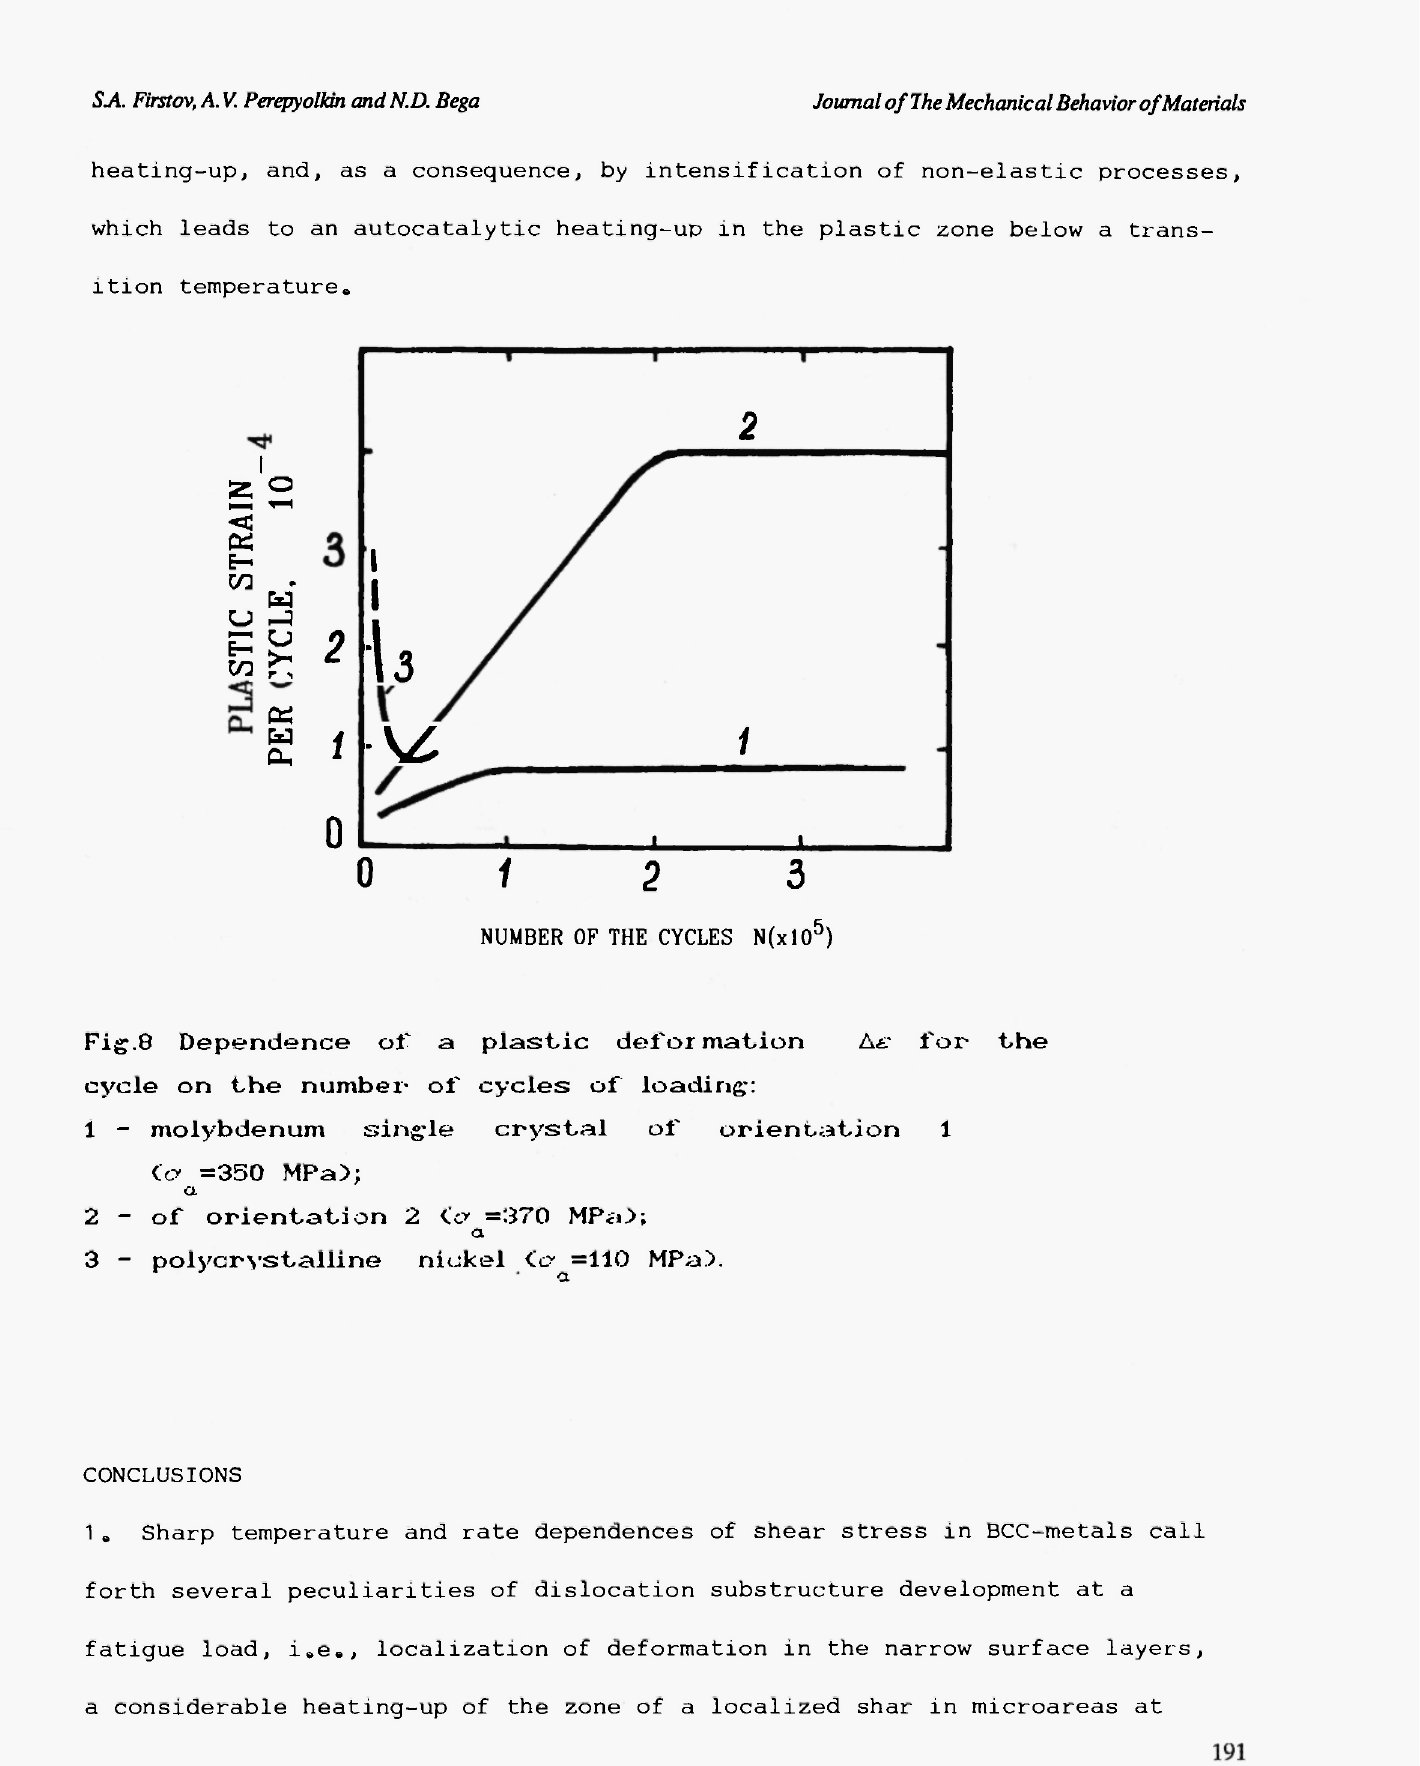
Fig.8 Dependence of a plastic d e f o r m a t i on Αέ.· f or the cycle on the number· of cycles of